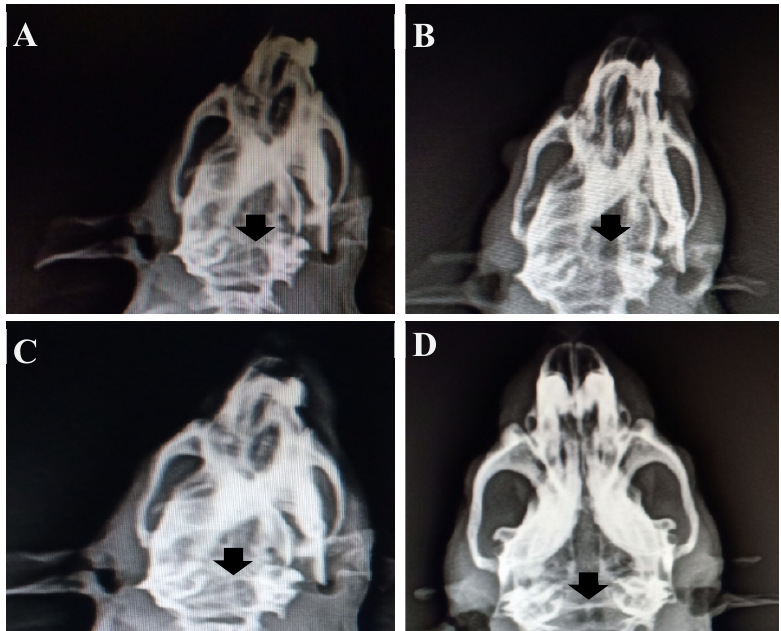
Figure 9. X-ray images of ( A ) without implantation at 4 weeks ( B ) HAP-HPC-PLA at 4 weeks ( C ) without implantation at 8 weeks ( D ) HAP-HPC-PLA at 8 weeks.